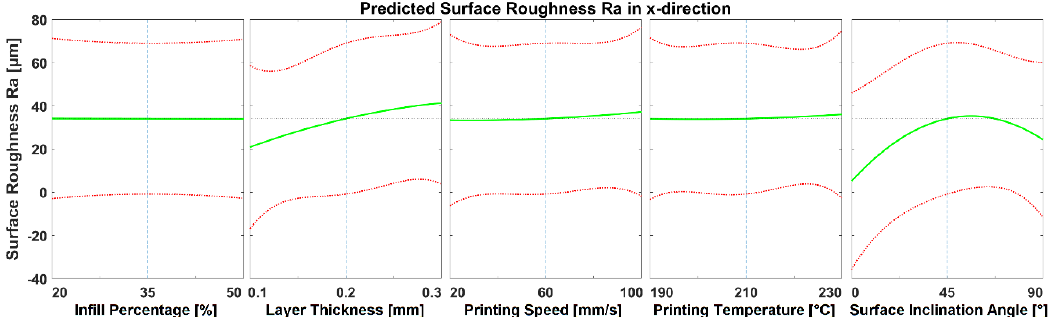
Figure 11. Predicted effects of changes in process parameters on the error% for surface roughness in the X direction.